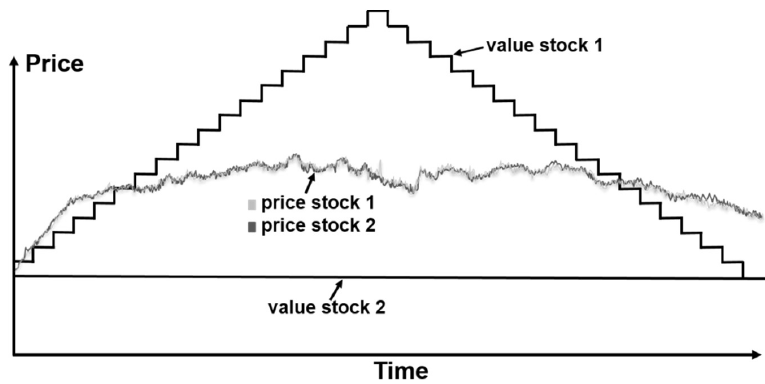
Figure 3. Single run of the simulation with no algorithmic traders in the market.